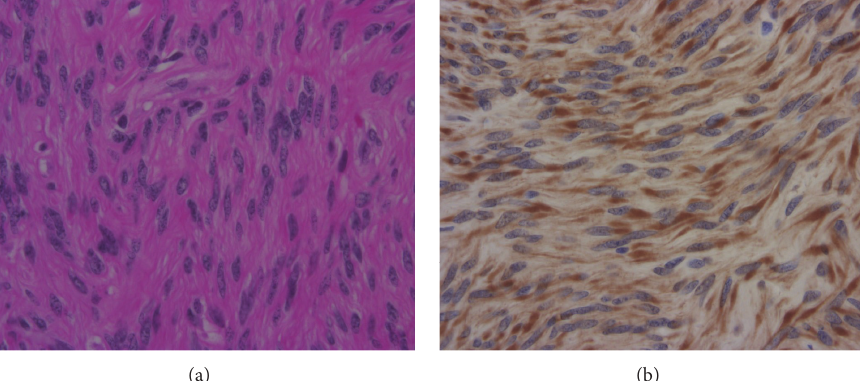
Figure 1: (a) Hematoxylin-eosin stain (HE stain). Uniform, spindle-shaped, smooth muscle cells are shown, which were considered to be uterine leiomyoma cells. (b) Specific immunostaining for erythropoietin was detected in the cytoplasm of the leiomyoma cells. The cytoplasm of most leiomyoma cells was strongly